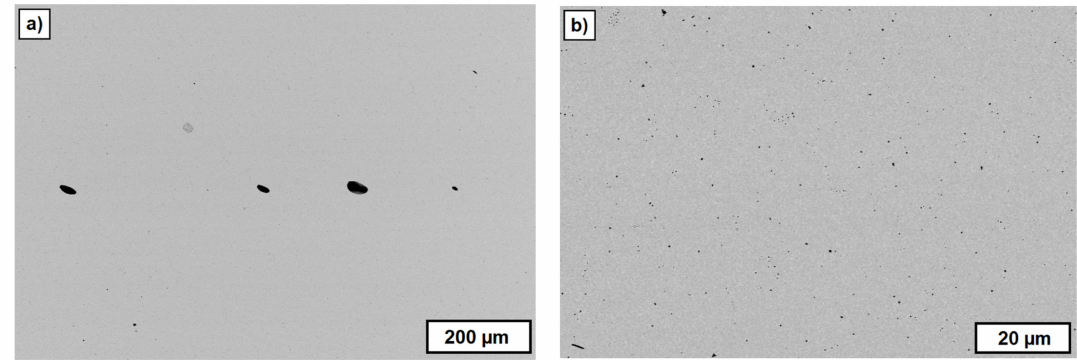
Figure 18. FESEM images of cross-sections of a test component with CERETAN MA 7008 as the PFA. ( a ) Overview; ( b ) detail.